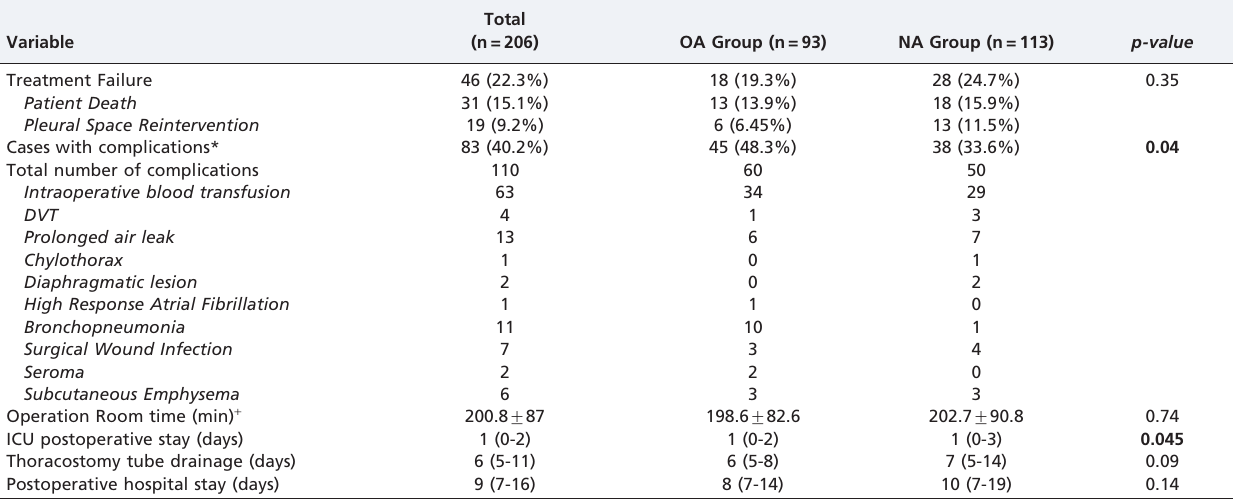
Table 2 - Variables defining treatment efficacy.